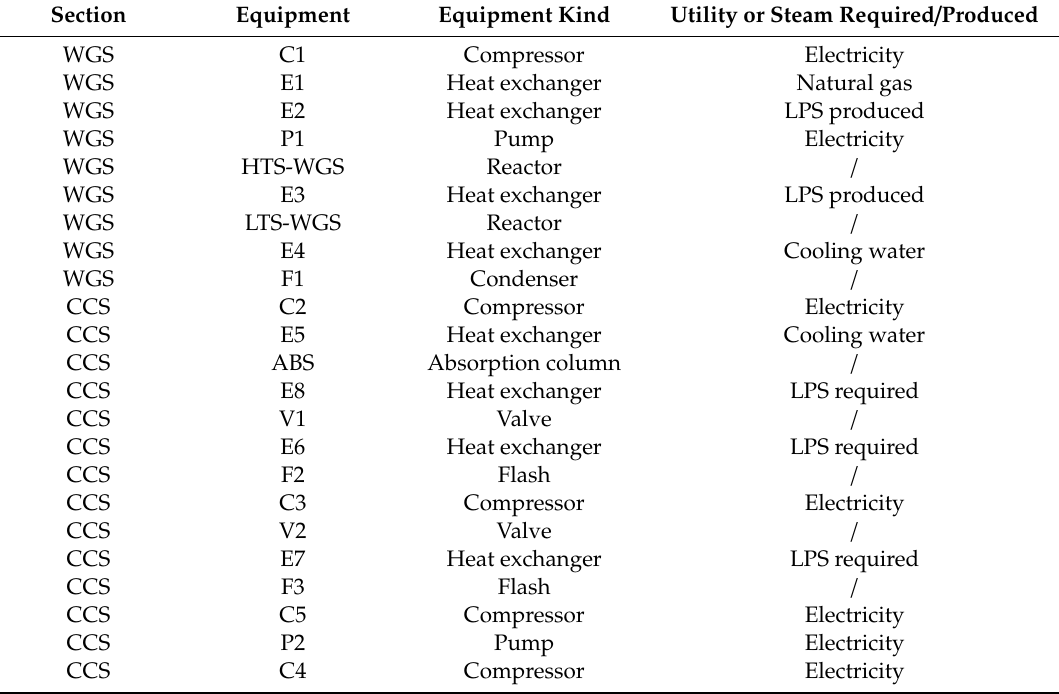
Table 2. Process equipment of the considered flowsheet of Figure